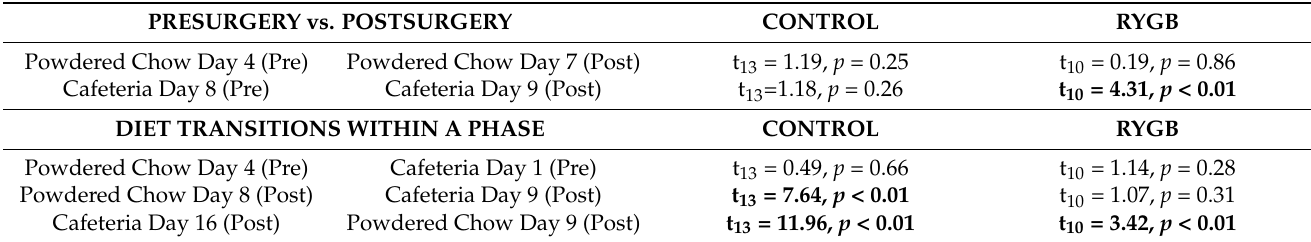
Table 3. Total Energy Intake within Groups across Phases and Diet